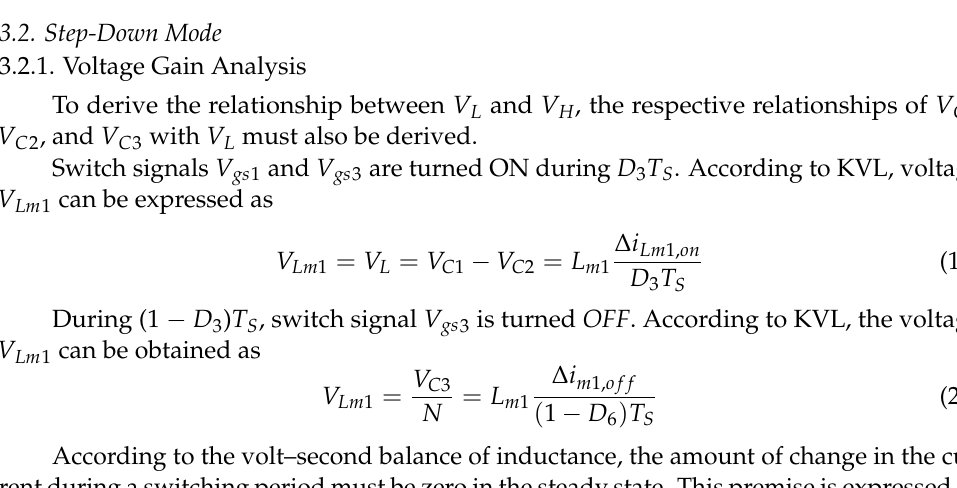
Figure 9. Curve of L m 1 ,BCM in the step-up mode.